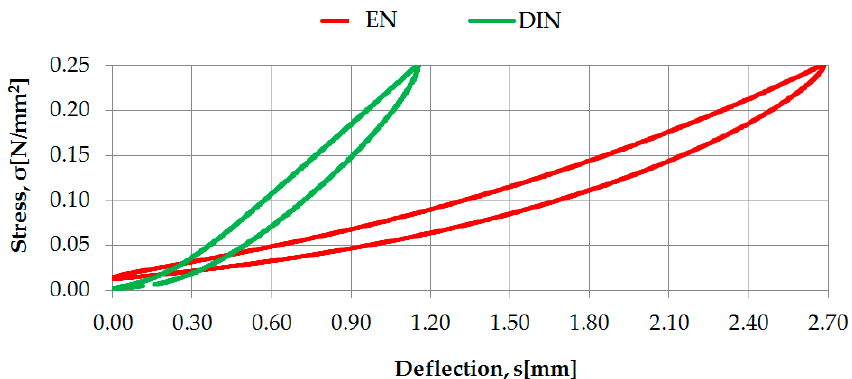
Figure 4. Static characteristics of UBM 045 determined according to DIN [23] and EN [24]. 3.2. Dynamic Bedding Modulus in Low Frequencies For all tested UBM samples the values of dynamic bedding modulus in low fre- quencies were determined (Table 9). A dynamic bedding modulus